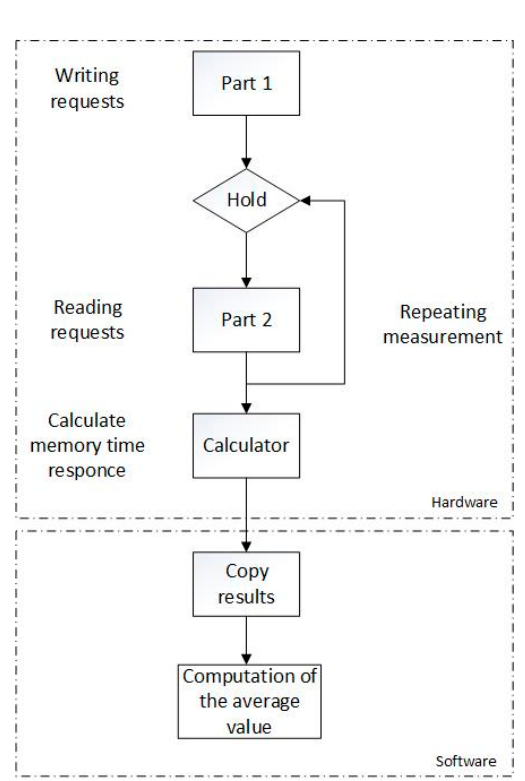
Figure 4. Experimental setup.